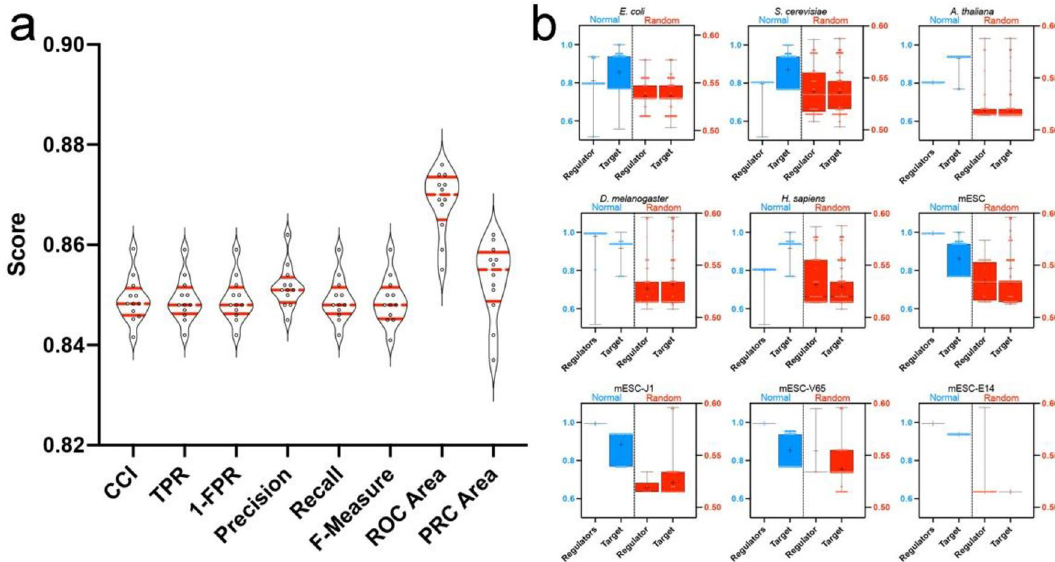
Figure 1. Predictive performances. ( a ) Predictive performances during supervised learning. CCI correctly classified instances, TPR true positive rate, 1-FPR one minus false positive rate, MCC Matthews correlation coefficient, ROC area receiver operating characteristic area under the curve, PRC area precision-recall curve; ( b ) predictive score of the consensus models over each test set. Blue boxes and the Y-left axis depict the classification using the normal consensus model (only the scores from CCI were plotted), whereas the red boxes and Y-right axis depict classification using the random model. The “+” indicates the mean. The Mann–Whitney test showed a p-value < 0.001 for all